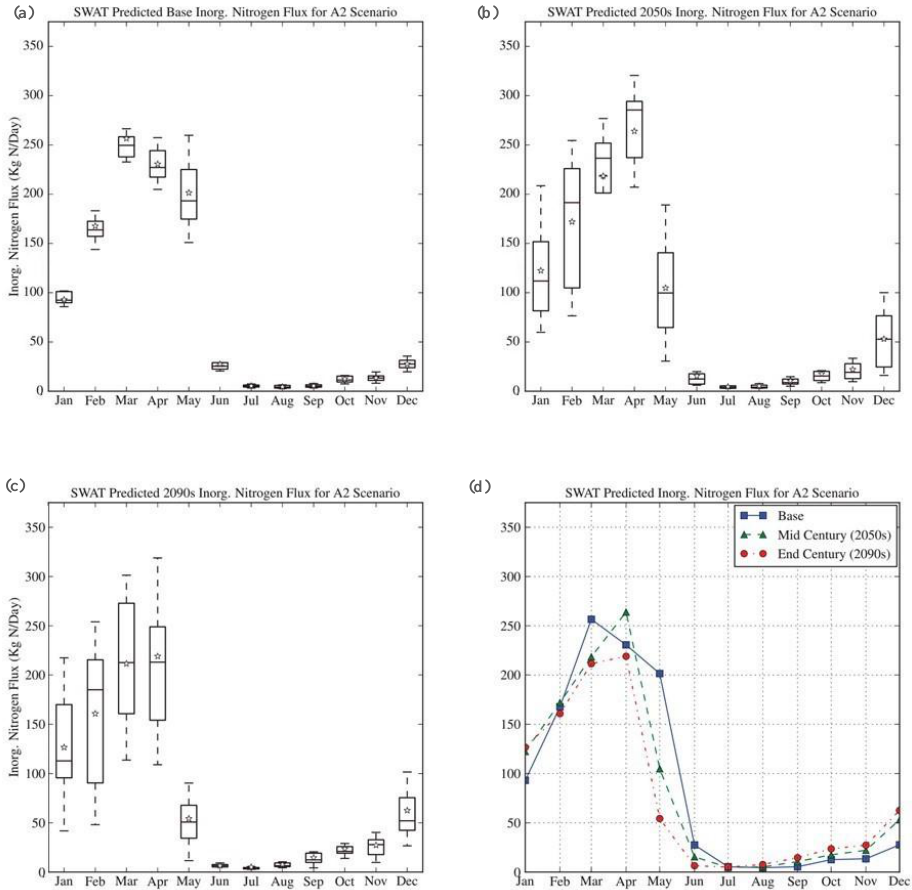
Figure 7. SWAT predicted monthly average inorganic nitrogen loading. ( a ) Base period (1970–2000); ( b ) Mid-Century (2048–2065); ( c ) End-Century (2085–2099); from eight GCMs predicted A2 emission scenarios at EPA station J0770000; and, ( d ) the average inorganic nitrogen loading over the eight GCMs for the three study periods.